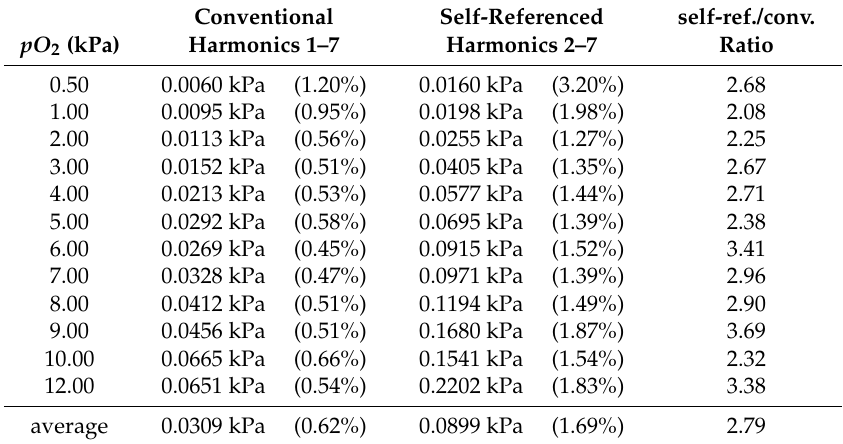
Table 1. Accuracy in the oxygen determination combining all the lifetimes from the different harmonics: comparison of the conventional and the self-referenced methods. Results corresponding to the evaluation